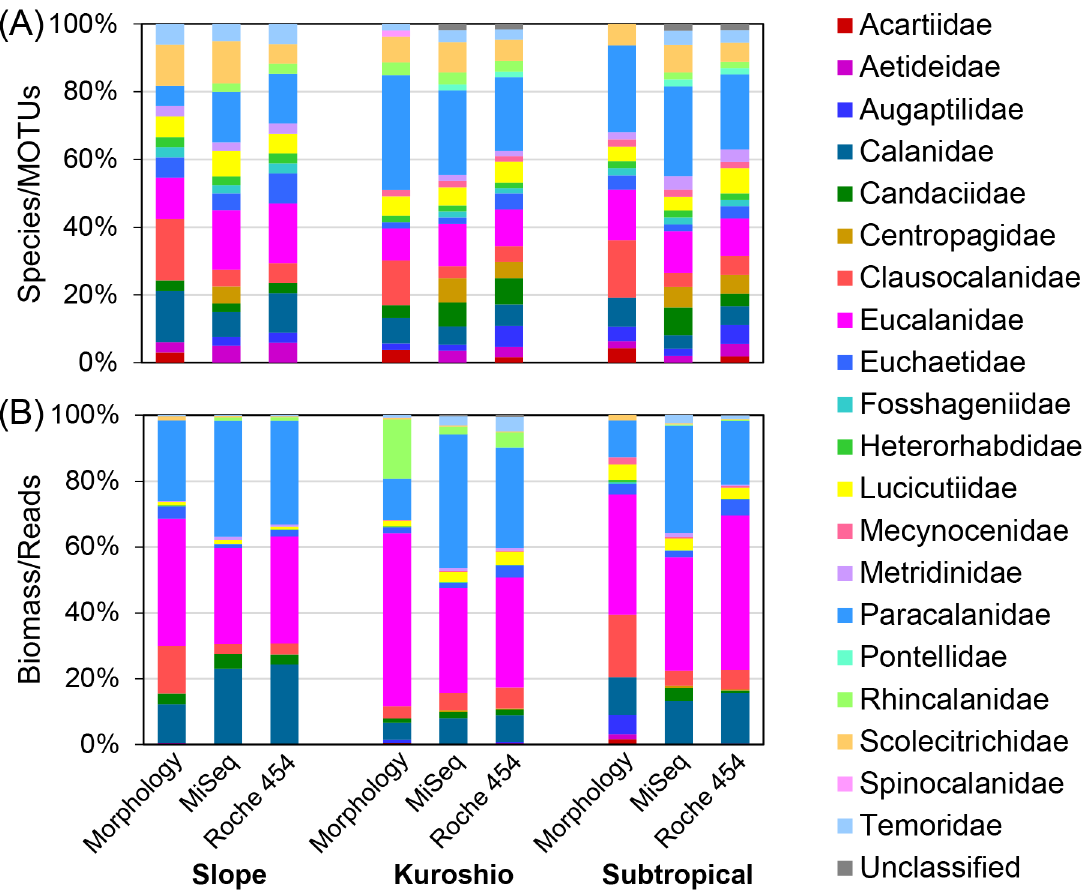
Fig 4. Family-level taxonomic compositions of calanoid copepods in field-collected samples between (A) species and MOTUs, and (B) biomass and sequence reads. Metagenetic analysesusing both Illumina MiSeq and Roche 454 data were performed at a 97% similarity